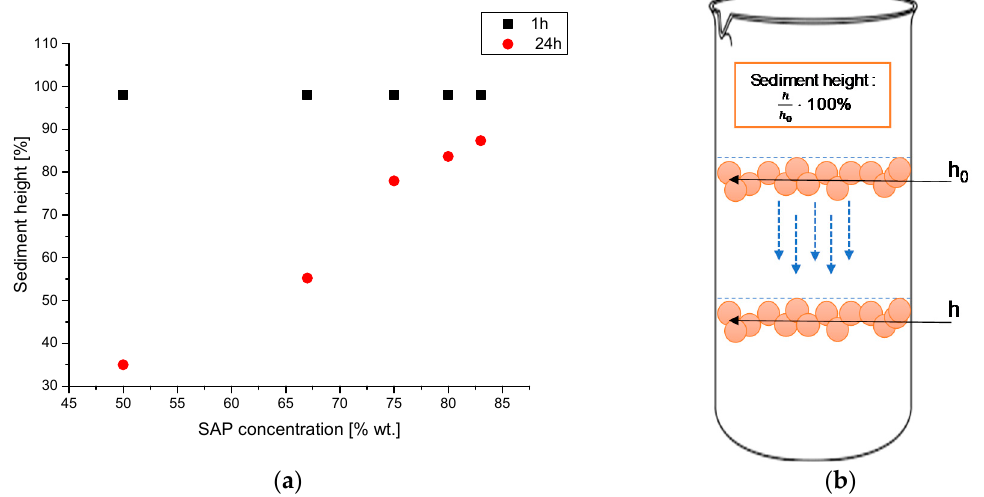
Figure 9. The sediment heights as a function of the SAP concentration in the tested suspensions ( a ) and the scheme of the tested sedimentation process ( b ).